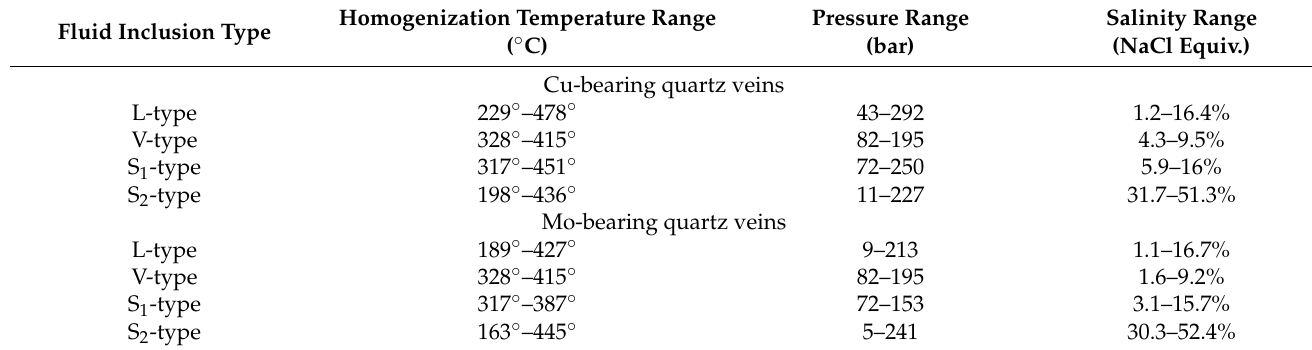
Table 1. Temperature, pressure and salinity ranges of fluid inclusions at the Jiama